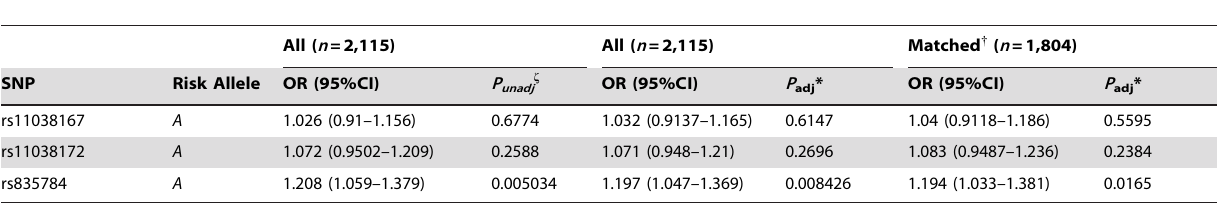
Table 4. Risk estimates using logistic regression model for three SNPs in TSPAN18.